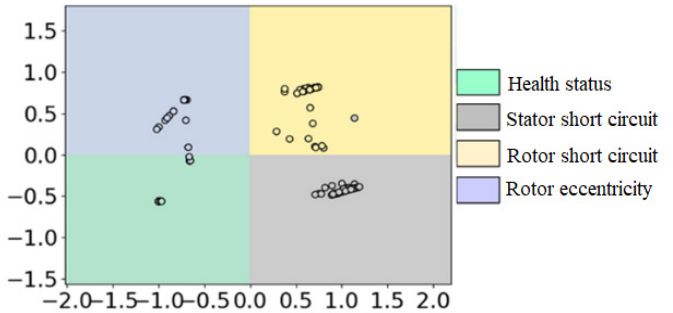
Figure 9. Classification result with the fuzzy process after removing the variation period of the radial unbalanced force direction.